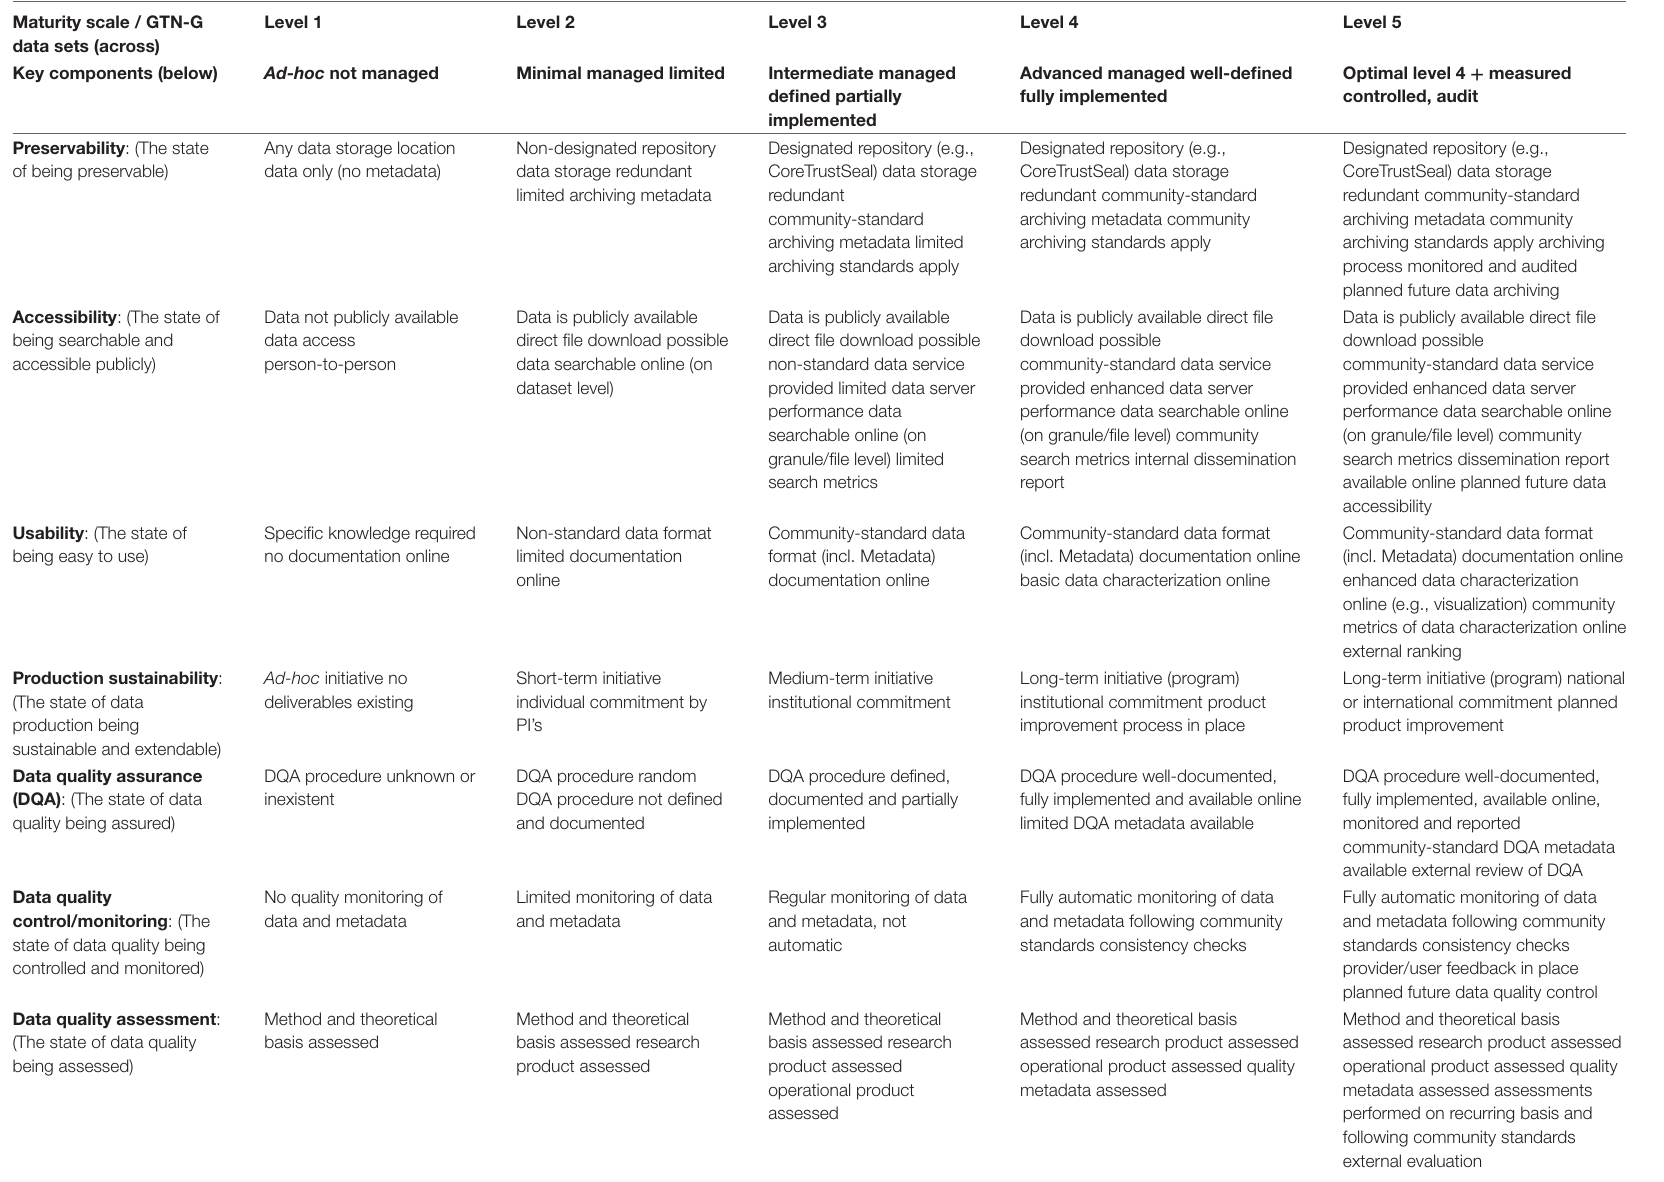
TABLE 1 | Maturity scale applied for the assessment of the GTN-G datasets [modified after Peng et al. (2015, 2019)]. Maturity scale / GTN-G data sets